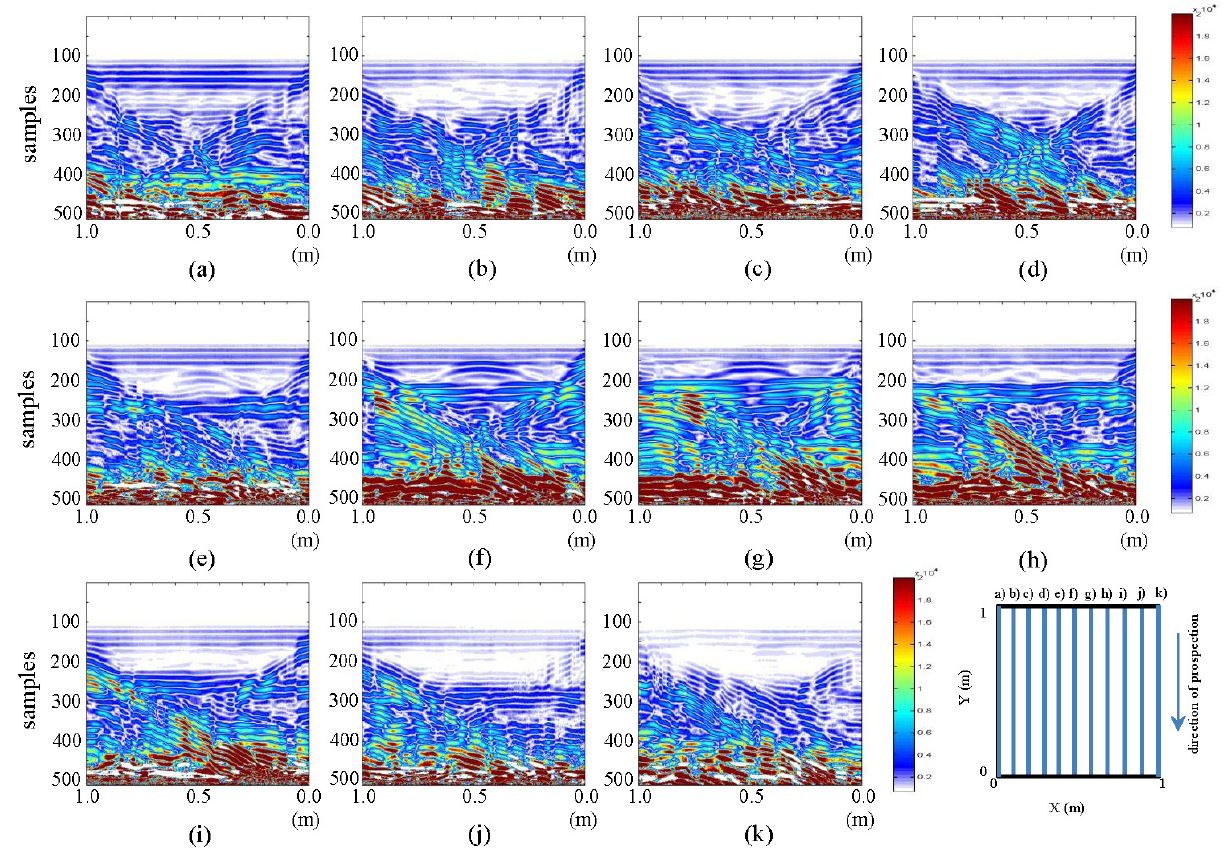
Figure 8. Vertical profiles: contrasting raw images for initial and final states. ( a – k ) are profiles s12 to s22,